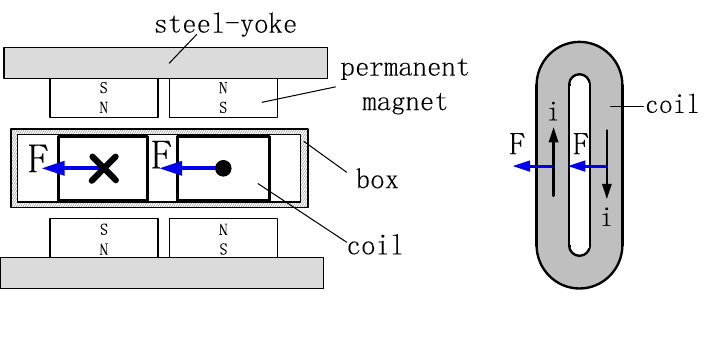
Figure 2. Simplified layout of the Lorentz motor.